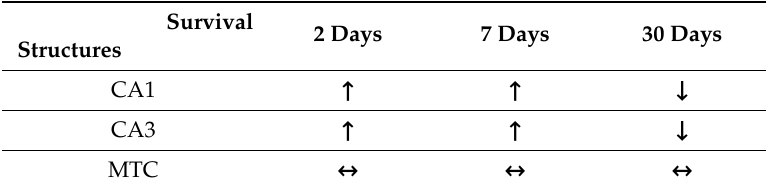
Table 2. Changes in the expression of the Alzheimer’s disease-associated β -secretase gene in di ff erent brain structures at di ff erent times after experimental brain ischemia. Survival 2 Days 7 Days 30 Days Structures CA1 ↑ ↑ ↓ CA3 ↓ ↓ ↑ MTC ↑ ↓ ↓